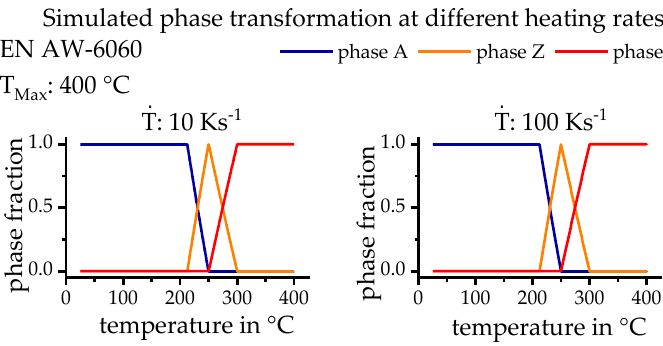
Figure 17. Simulated phase transformations at different heating rates up to 400 °C.